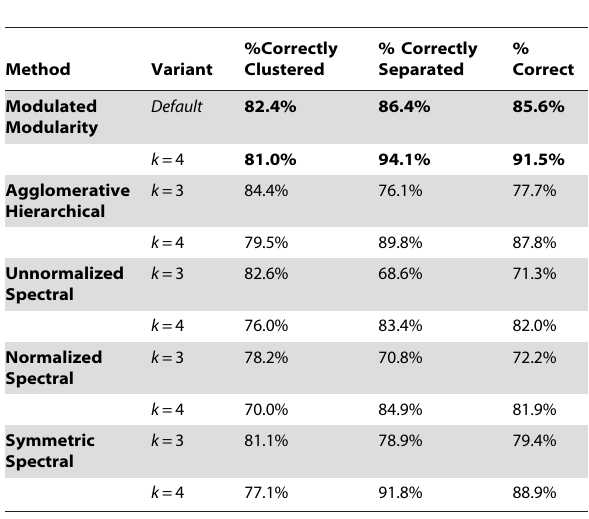
Table 1. Comparison of Clustering Methods over 10,000 Simulated